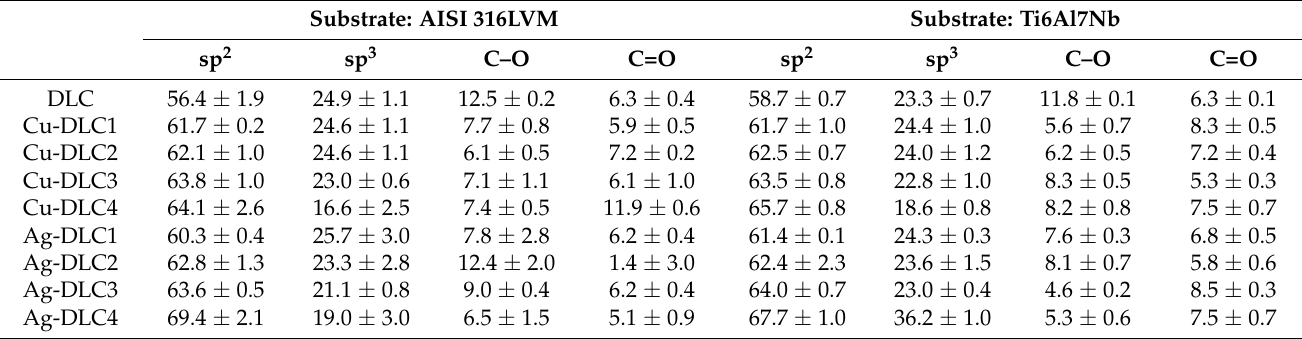
Table 3. Analysis of C1s peak—percentage content of bonds that were present in X-DLC